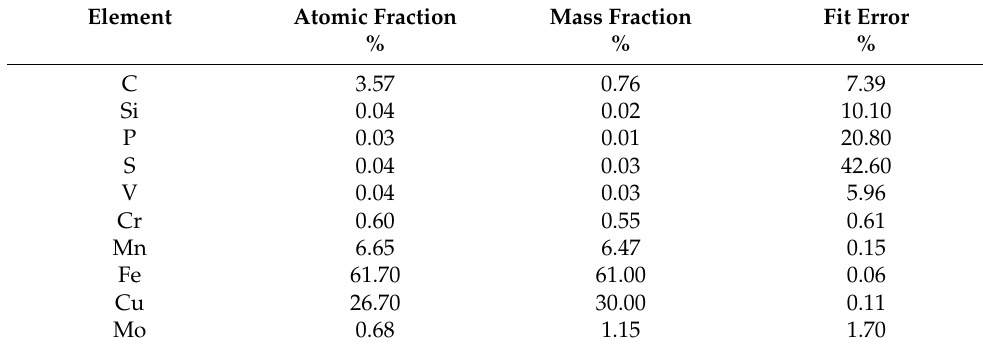
Table 2. Composition of the precipitates.